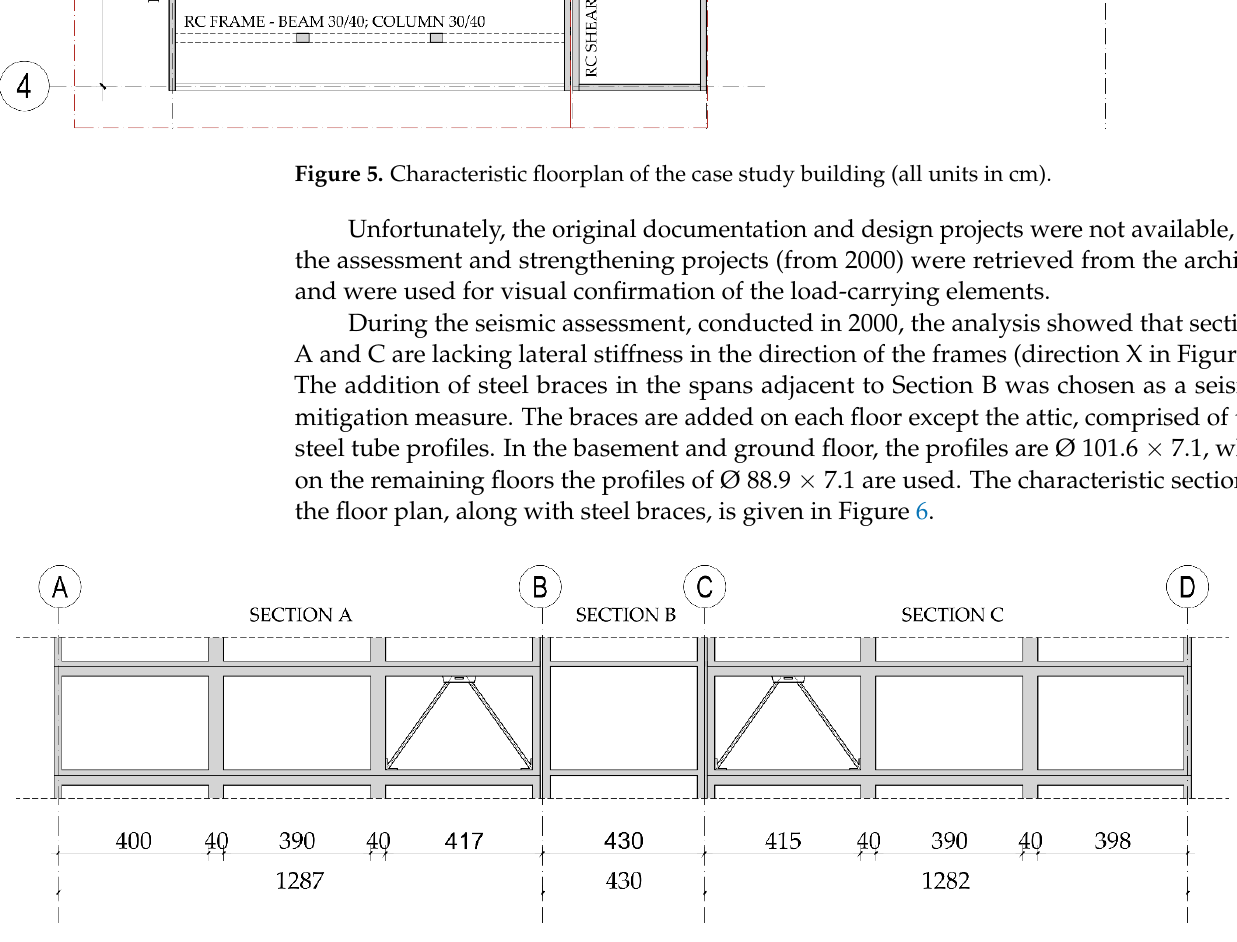
Figure 6. Sectional plan of case study building with visible steel braces.